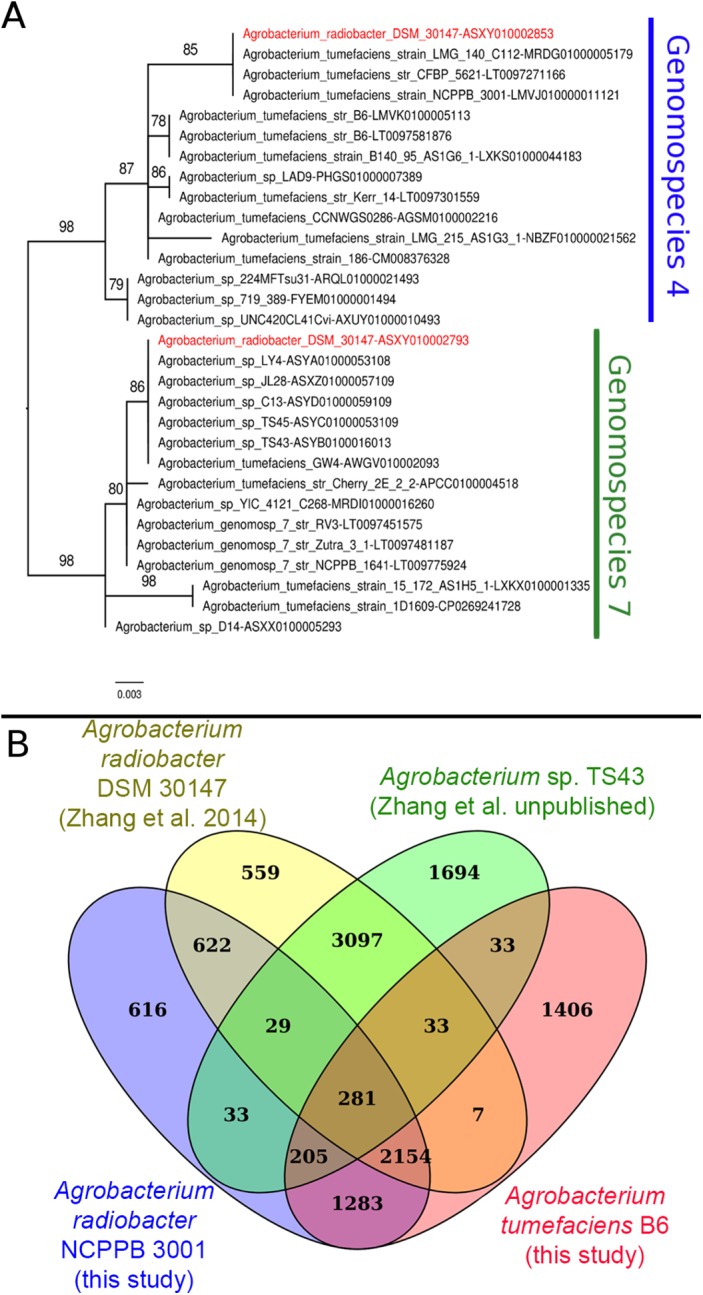
Phylogenetic and genomic evidence indicating contamination in the published A. radiobacter DSM 30147T genome.(A) Maximum likelihood phylogenetic tree of seryl-tRNA synthetases from Agrobacterium genomospecies 4 and 7. Codes after the tildes are contigs containing the corresponding homologs. Node labels indicate ultra-fast bootstrap support value and branch length indicates number of substitutions per site. Duplicated homologs in the problematic A. radiobacter DSM 30147 genome were colored red. (B) Venn diagram of the core proteome of selected Agrobacterium strains from genomospecies 4. Numbers in the overlapping regions indicate the number of coding sequences (CDS) that shared by two or more groups at 95% nucleotide identity cutoff.